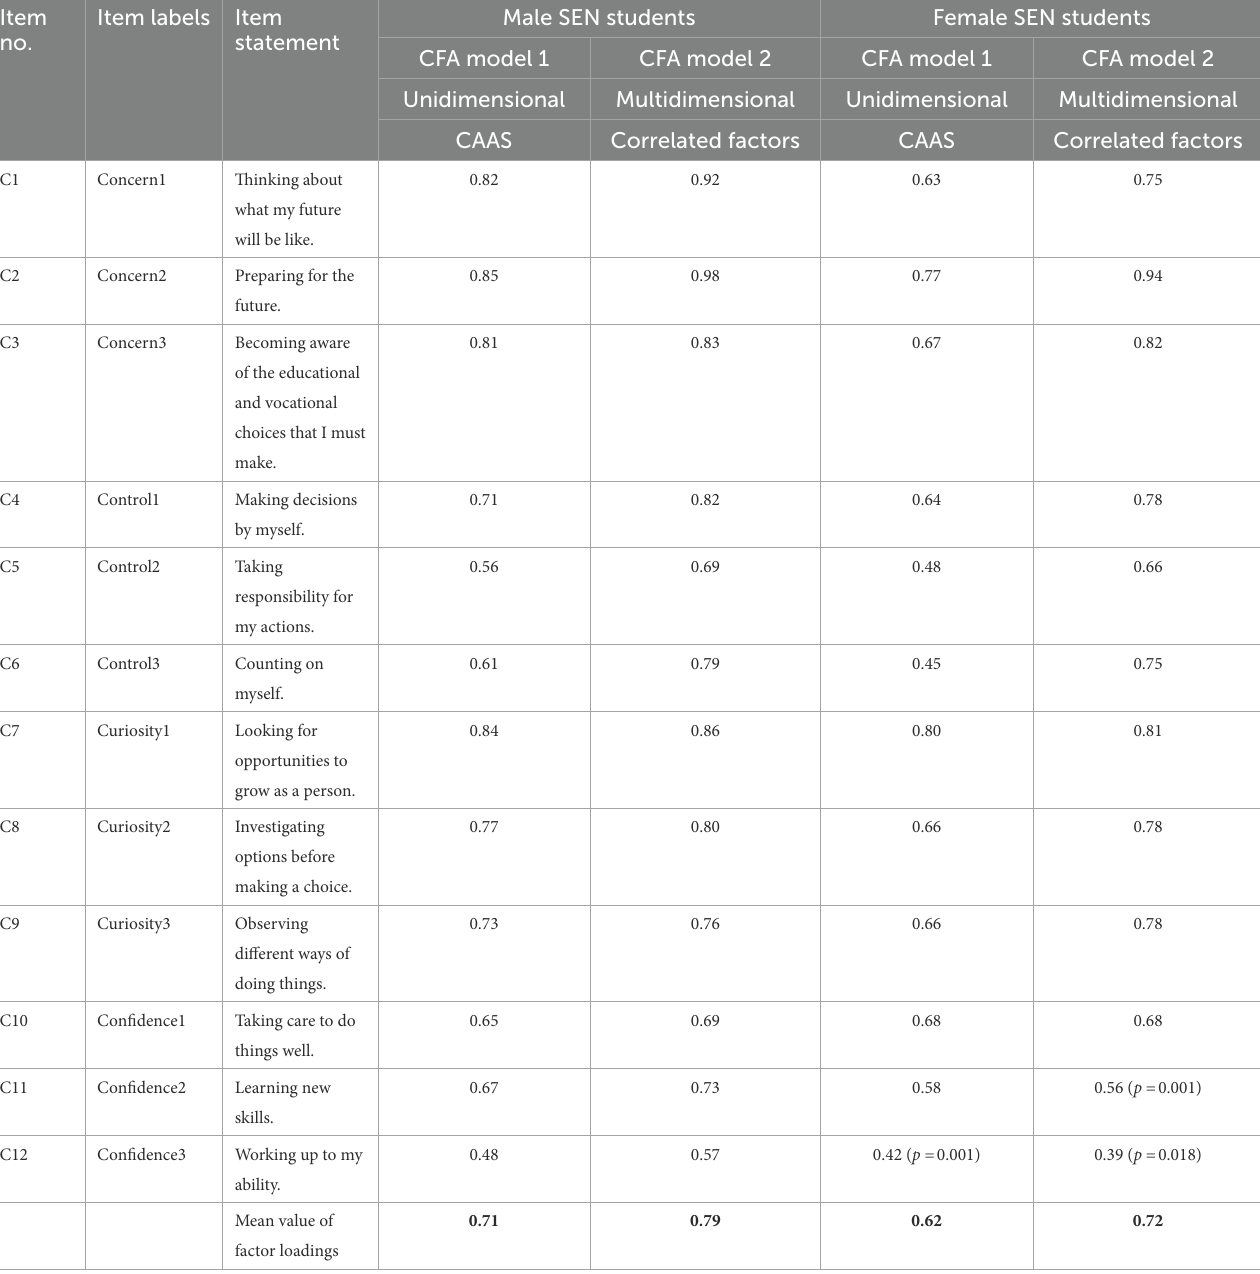
TABLE A.1 Standardized factors loadings of the general factor and correlated factors models (Models 1 and 2 in Figure 1) for male and female SEN students. Item